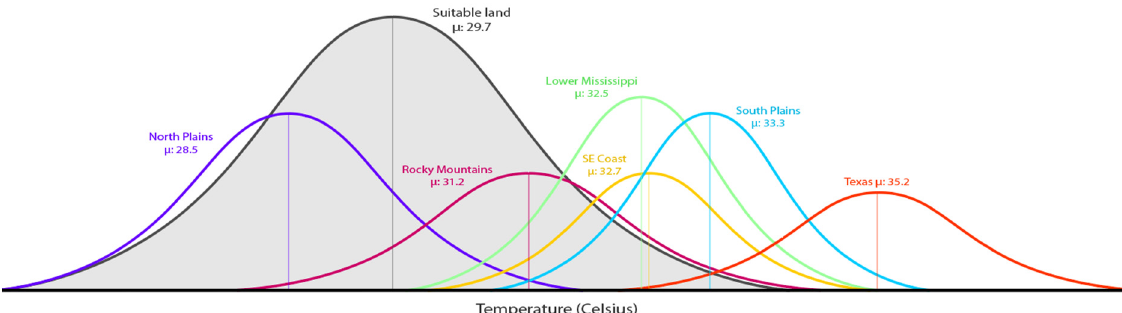
Figure 10. Comparison between suitable and unsuitable presence regions for mean temperature of the warmest quarter.